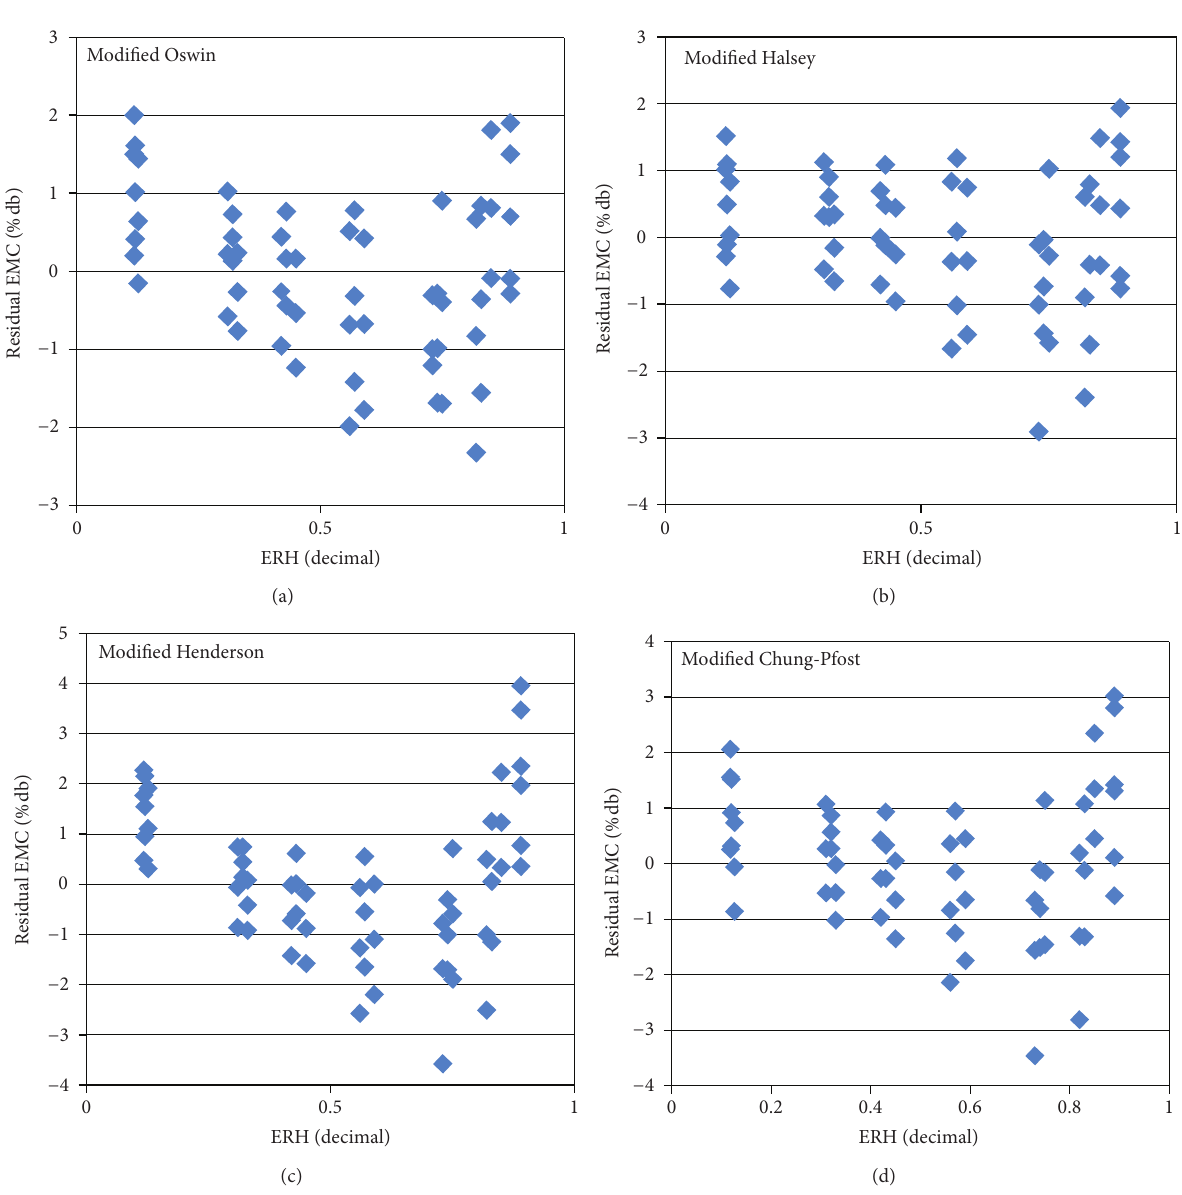
different temperatures (20, 30, and 40 ∘ C). The closeness of observed EMC data (points) and predicted EMC (line) confirms the goodness of model fit for both feedstocks.